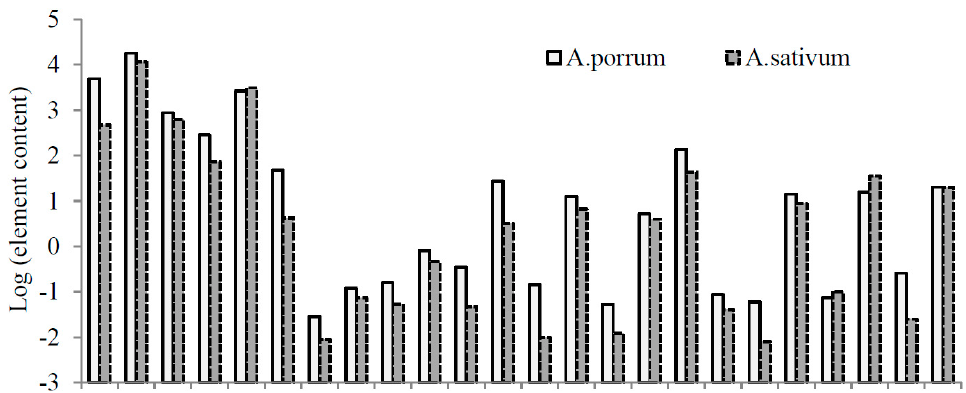
Figure 6. Comparative elemental profile of leek and winter garlic [42] grown in the same geochemical conditions of the Moscow region.